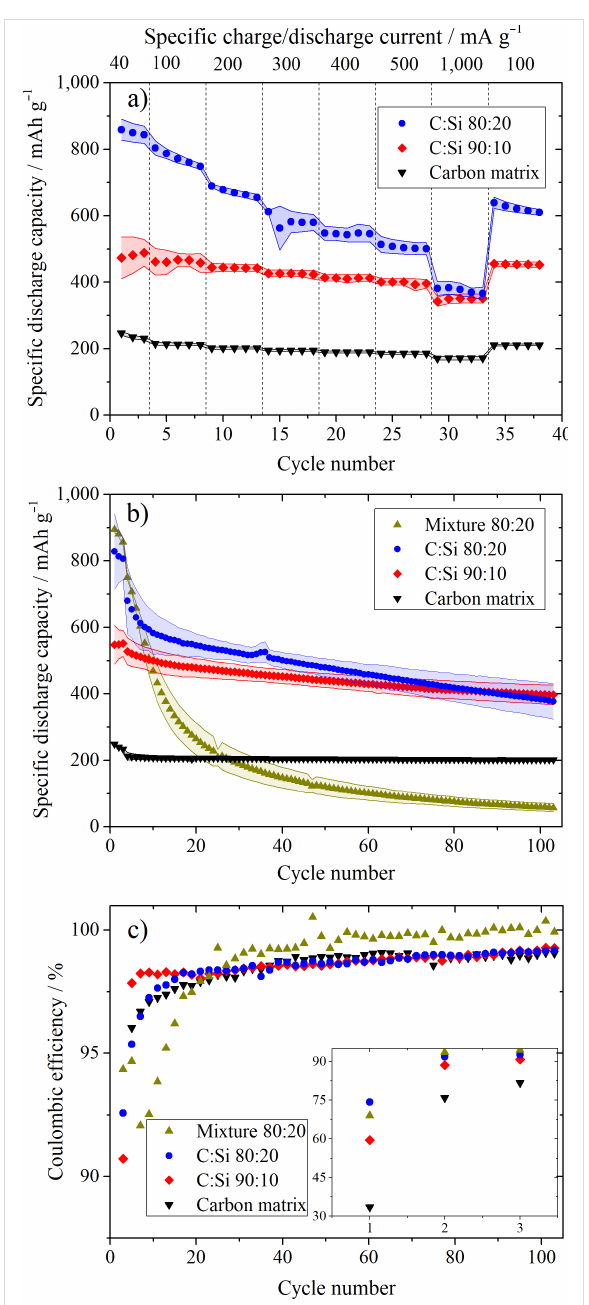
Figure 4: Constant current rate performance investigations at different charge/discharge currents (a) of the Si/C composites with a carbon to silicon ratio of 100:0, 90:10, 80:20 and constant current long-term cycling experiments (b) at a specific charge/discharge current of 400 mA g − 1 after three formation cycles at 80 mA g − 1 and the corre- sponding Coulombic efficiencies (c). In addition to the synthesized ma- terials, a physical mixture of the pure carbon matrix and the Si-NPs is shown in b and c. CE and RE: metallic lithium; potential range 0.02 V and 1.5 V vs Li/Li + (a) and 0.01 V and 1.5 V vs Li/Li + (b, c).